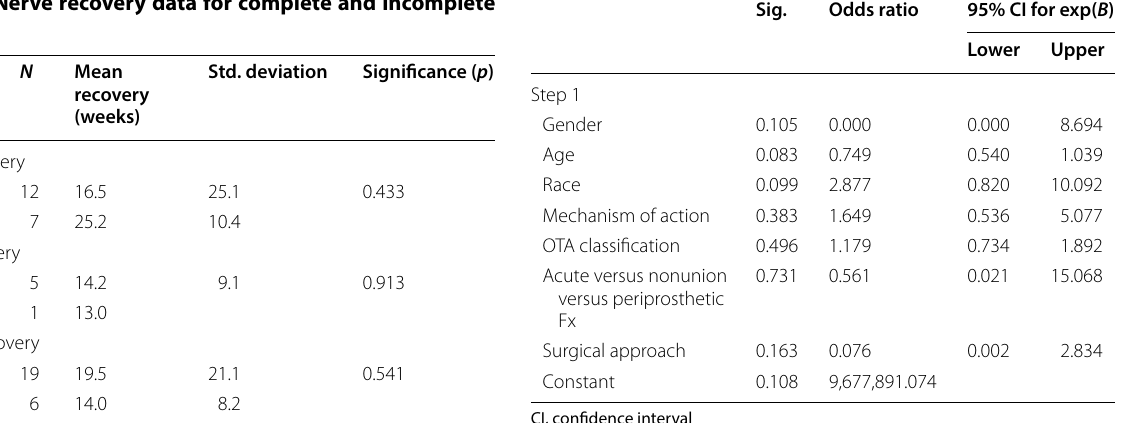
CI, confidence interval